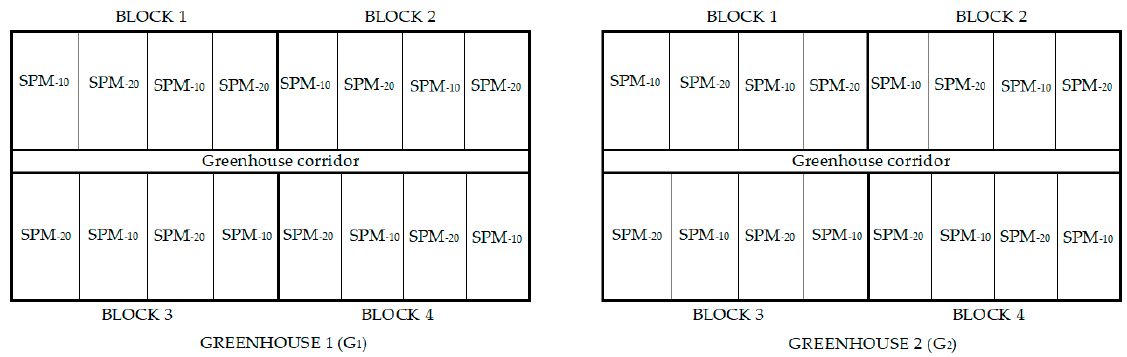
Figure 1. Experimental design.